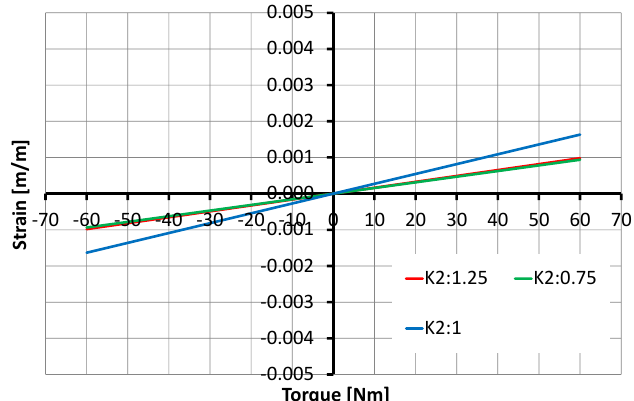
Figure 17. Relationship between the torque and the strain depending on design parameter K 2 : the 25% of variation influences torque sensor